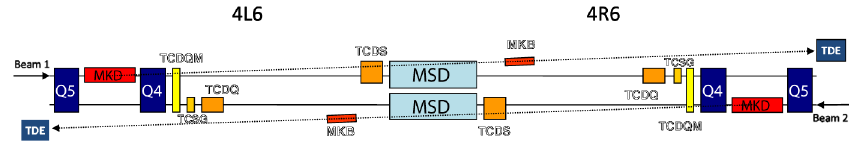
FIG. 4. (Color) An overview of the LHC beam dump region.